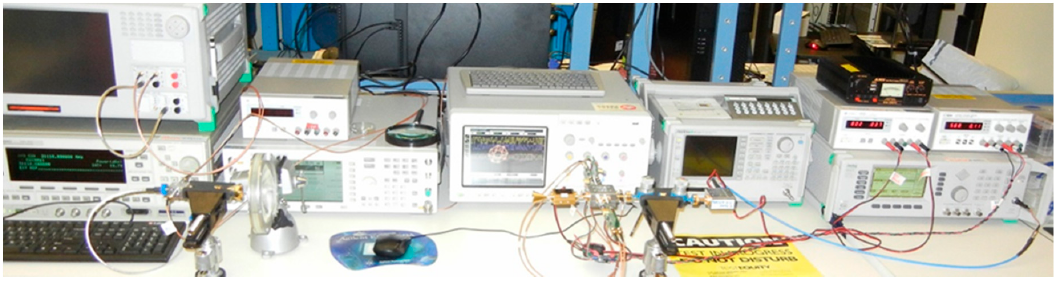
Figure 42. V-band multi-port test bench (version II).